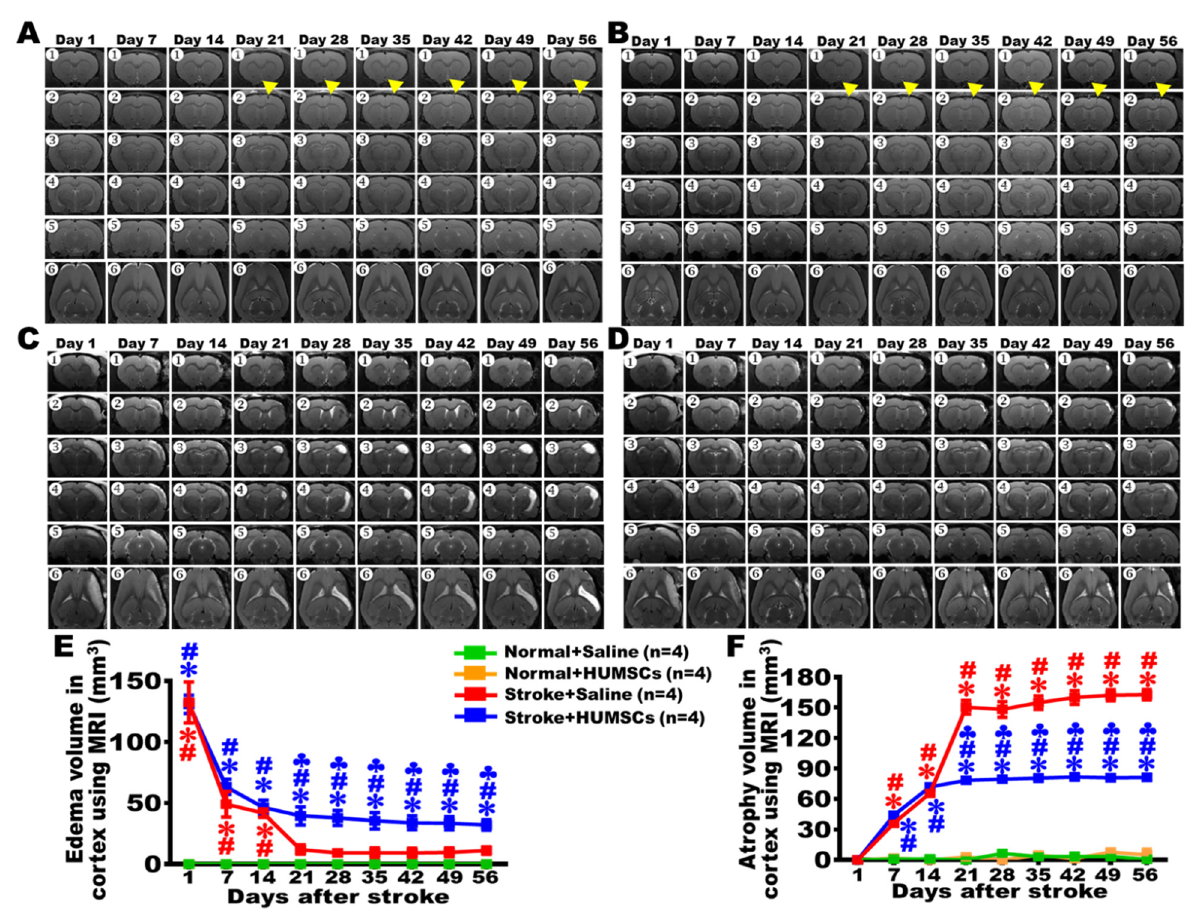
Figure 2. Cortical edema and atrophy examined by MRI. Brain MRI examination was conducted on day 1 ( – ), day 7 ( – ), day 14 ( – ), day 21 ( – ), day 28 ( – ), day 35 ( – ), day 42 ( – ), day 49 ( – ), and day 56 ( – ). Along the rostral–caudal orientation, coronal slices ( – ) and horizontal slices ( ) were taken for monitoring the alterations of brain damages in these rats. MRI slices of the Normal + Saline ( A ) and Normal + HUMSCs ( B ) groups did not find significant edema or atrophy areas from day 1 to day 56. MRI slices of the Stroke + Saline group ( C ) and the Stroke + HUMSCs group ( D ) were obtained on day 1 post stroke. White areas in the right cerebral cortex were seen, indicating severe inflammation and edema occurred in this region ( – ). On day 7 and day 14, there was a reduction in the white edema cortices, but slight atrophy had appeared in the right infarcted area when comparing to the left cerebral cortex ( – ). The volumes of edema ( E ) and atrophy ( F ) in the right cerebral cortex were quantified post stroke. Atrophy of the infarcted cortex becomes apparent in the Stroke + Saline group but is significantly less severe in the Stroke + HUMSCs group from day 21 to day 56. The results of brain MRI revealed that HUMSCs transplantation alleviated cerebral atrophy in rats with chronic stroke. Normal + Saline n = 4, Normal + HUMSCs n = 4, Stroke + Saline n = 4, Stroke + HUMSCs n = 4. ∗ , vs. the Normal + Saline group at the same day, p < 0.05. #, vs. the Normal + HUMSCs group at the same day, p < 0.05. ♣ , vs. the Stroke + Saline group at the same day, p < 0.05. indicates the first injection site.